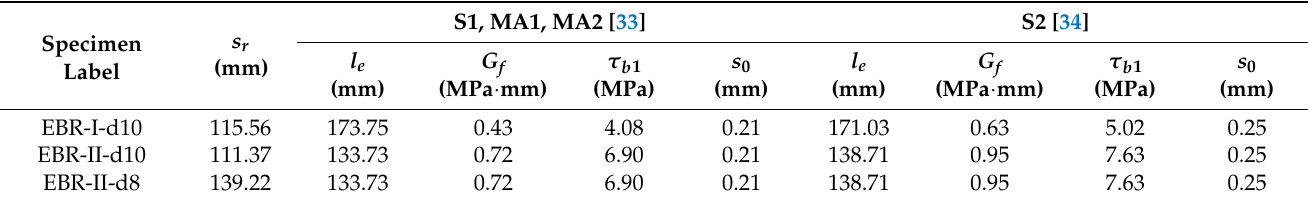
Table 5. Theoretical parameters of the bond law used in the different